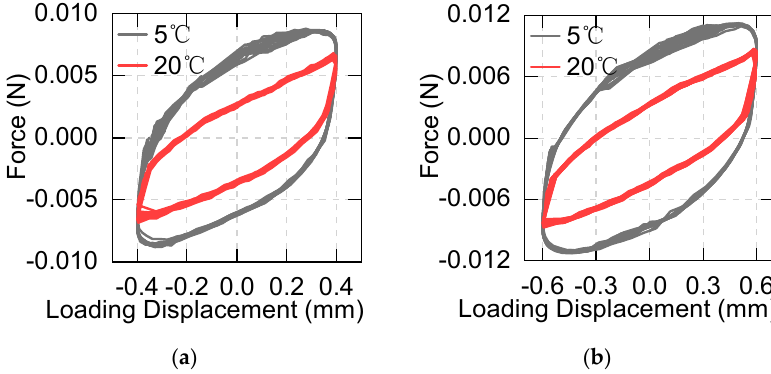
Figure 8. Hysteretic curves of the asphalt specimen under different temperatures at 0.1 Hz: ( a ) maximum displacement of 0.4 mm; ( b ) maximum displacement of 0.6 mm.